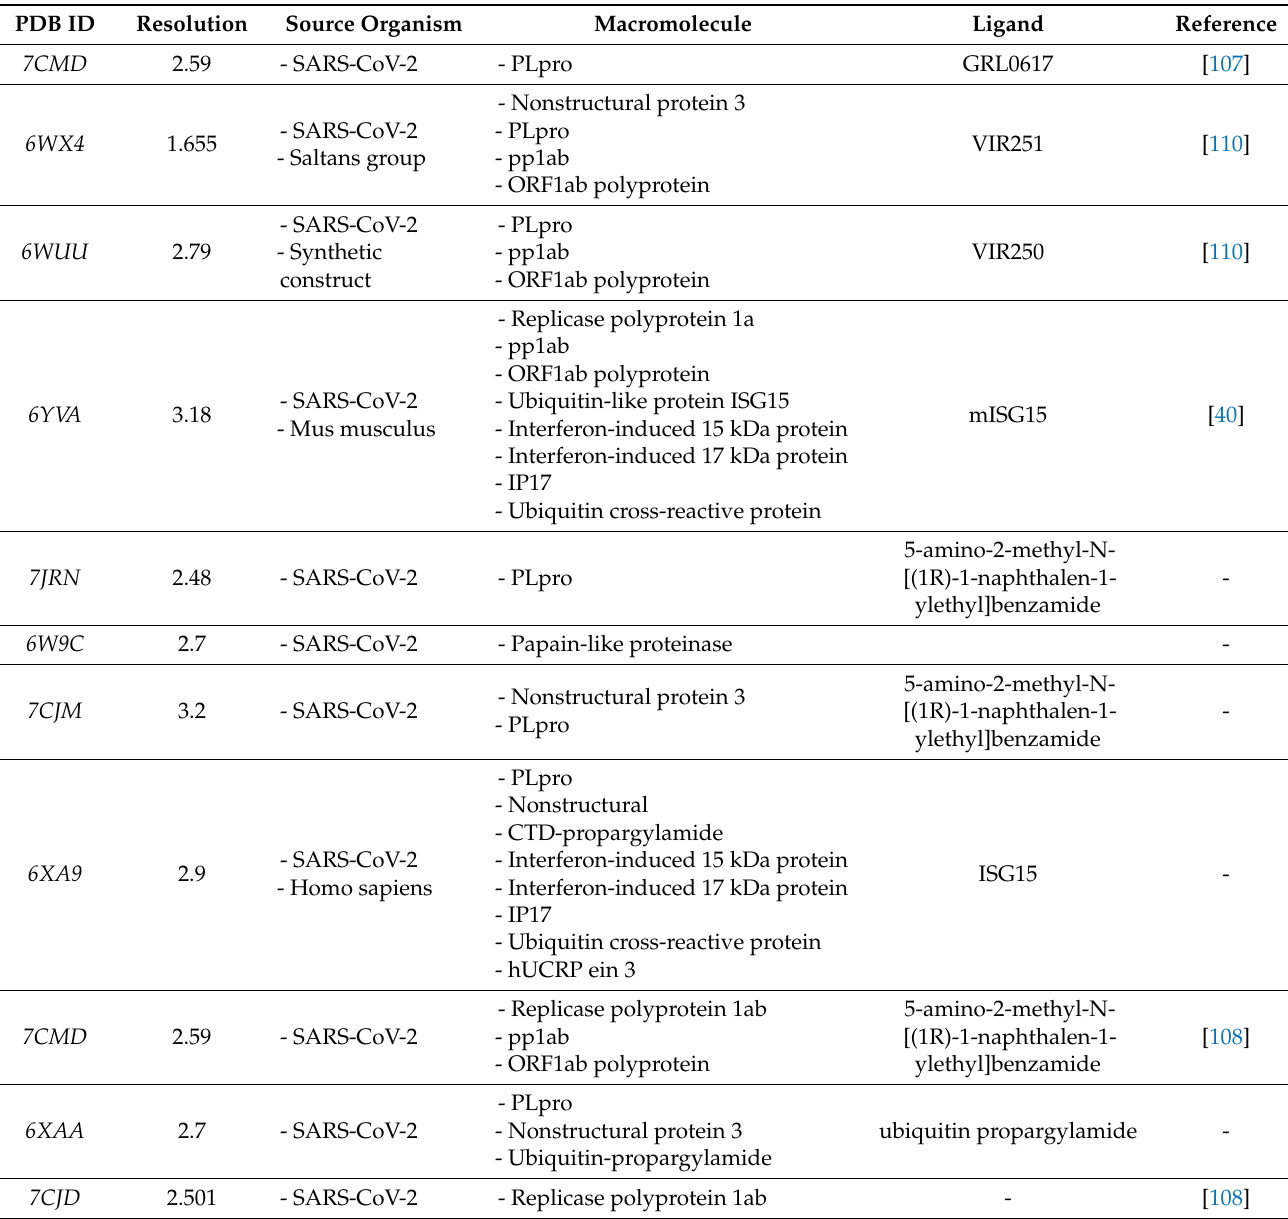
Table 2. The known 3D structures of Papain-like protease (PLpro) available on protein data bank (PDB). PDB